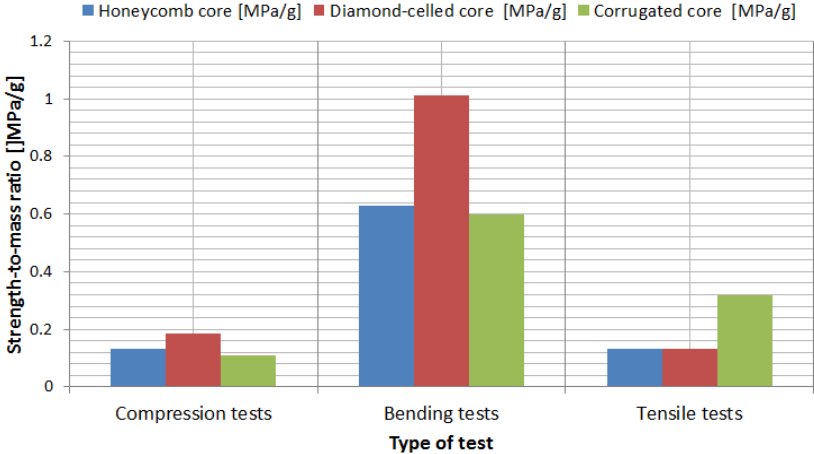
Figure 17. Strength-to-mass ratio analysis of the sandwich specimens.